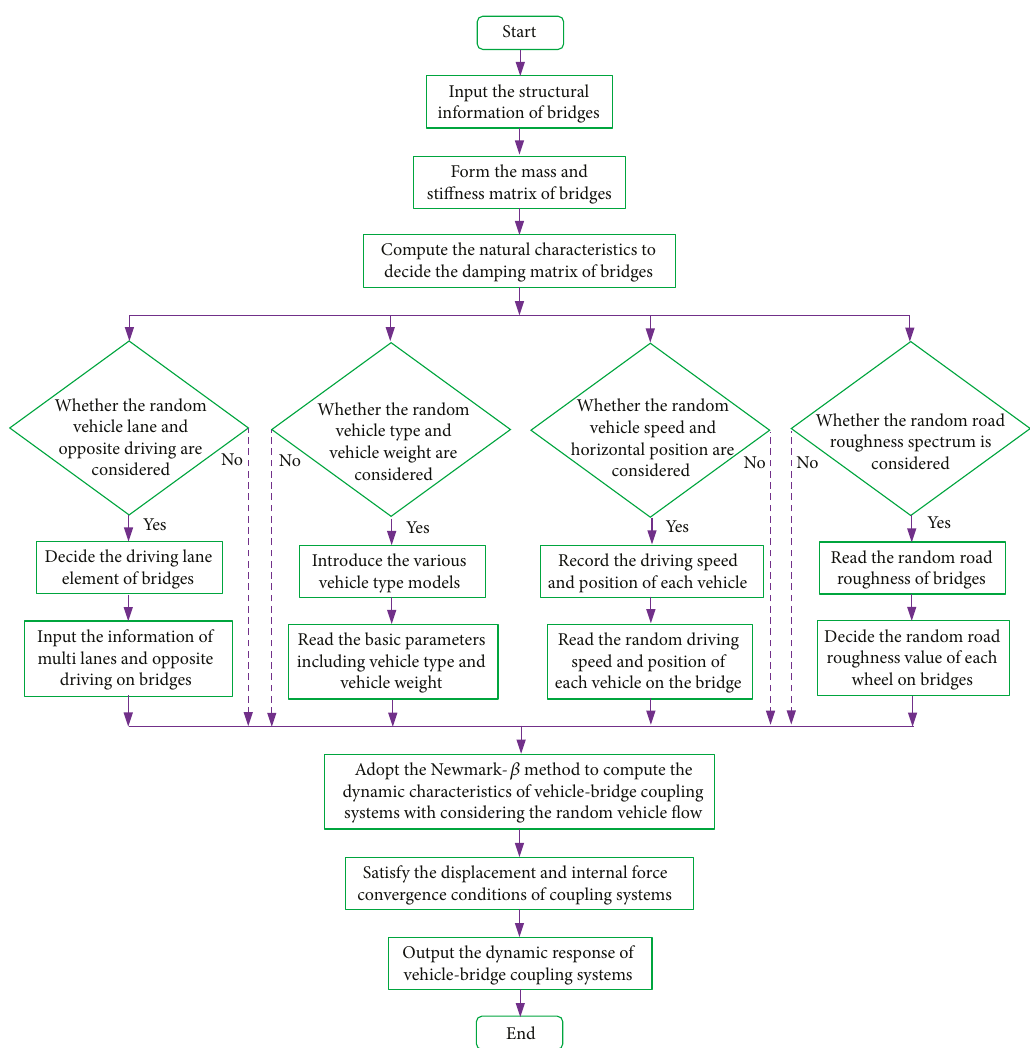
Figure 8: Solution processes of vehicle-bridge coupling